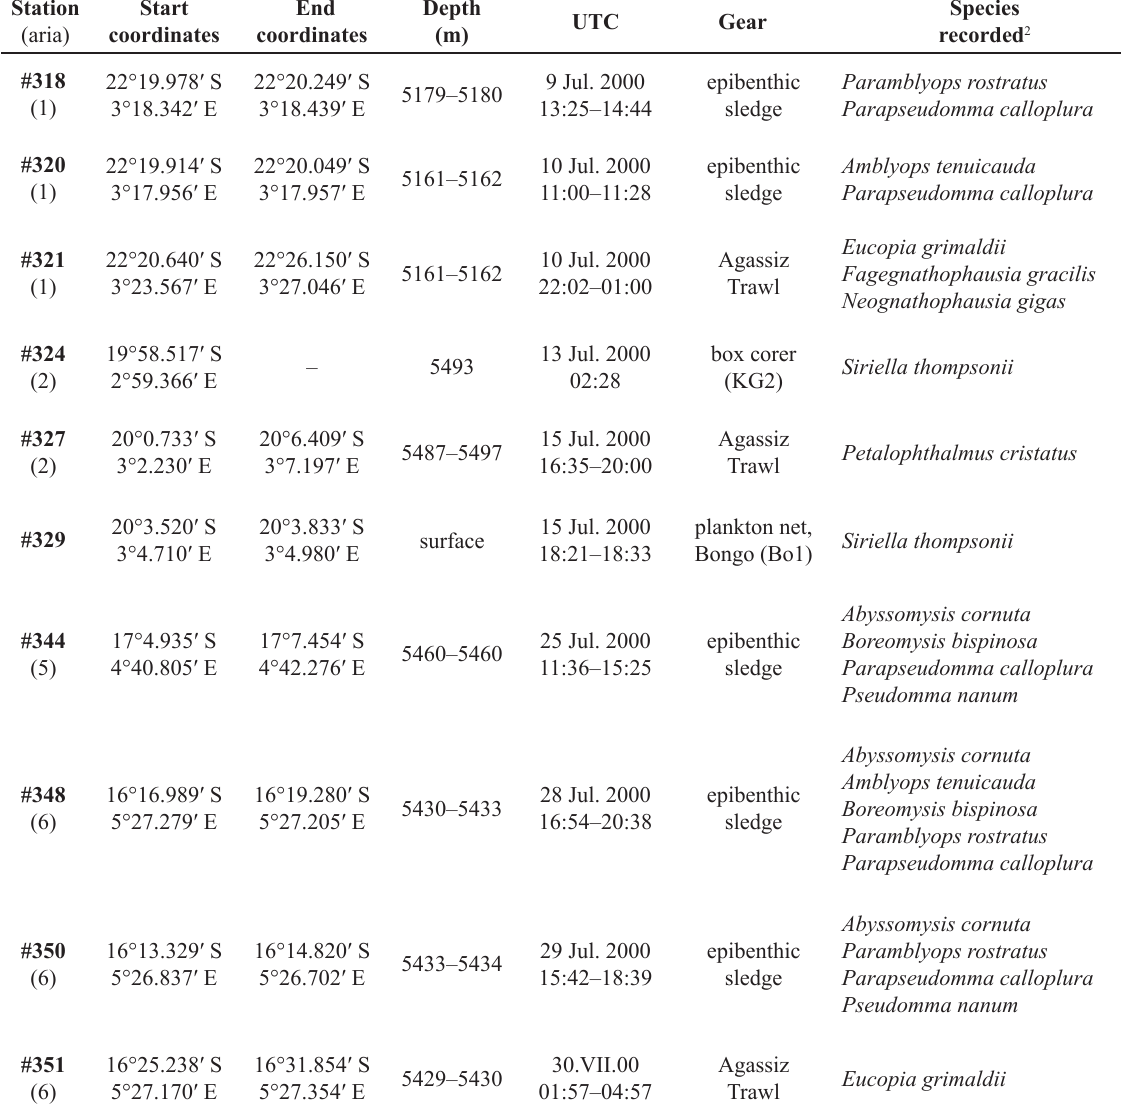
Table 1. Sampling data 1 of the “METEOR” cruise 48 leg 1 to the Angola Basin, SE-Atlantic: Lophogastrida and